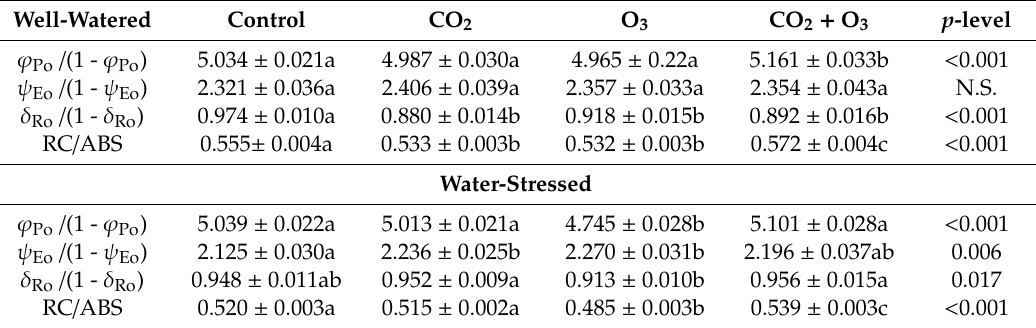
Table 2. The effect of elevated CO 2 , O 3 and CO 2 + O 3 on the components of the PI total in wheat plants under well-watered and water-stressed conditions. Values are means of weeks and SE. Different letters in the same row indicate statistically significant differences between the treatments ( p < 0.05 ).